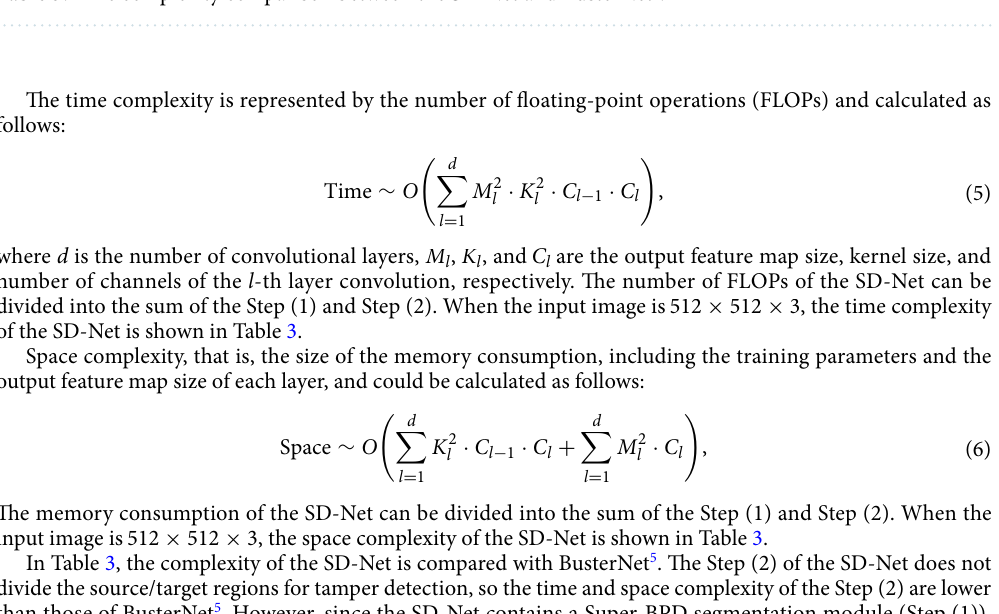
Table 3. The complexity comparison between the SD-Net and BusterNet 5